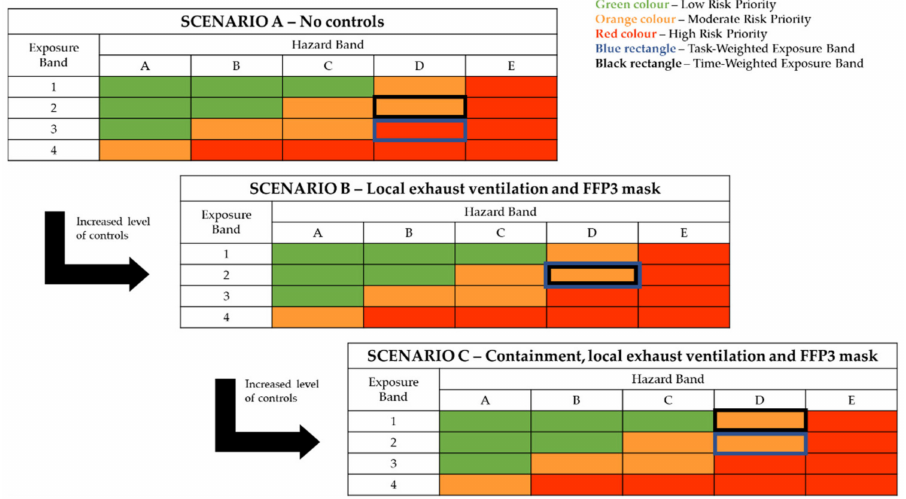
Figure 3. Control-banding classification of silver nanoparticles handling through Stoffenmanager